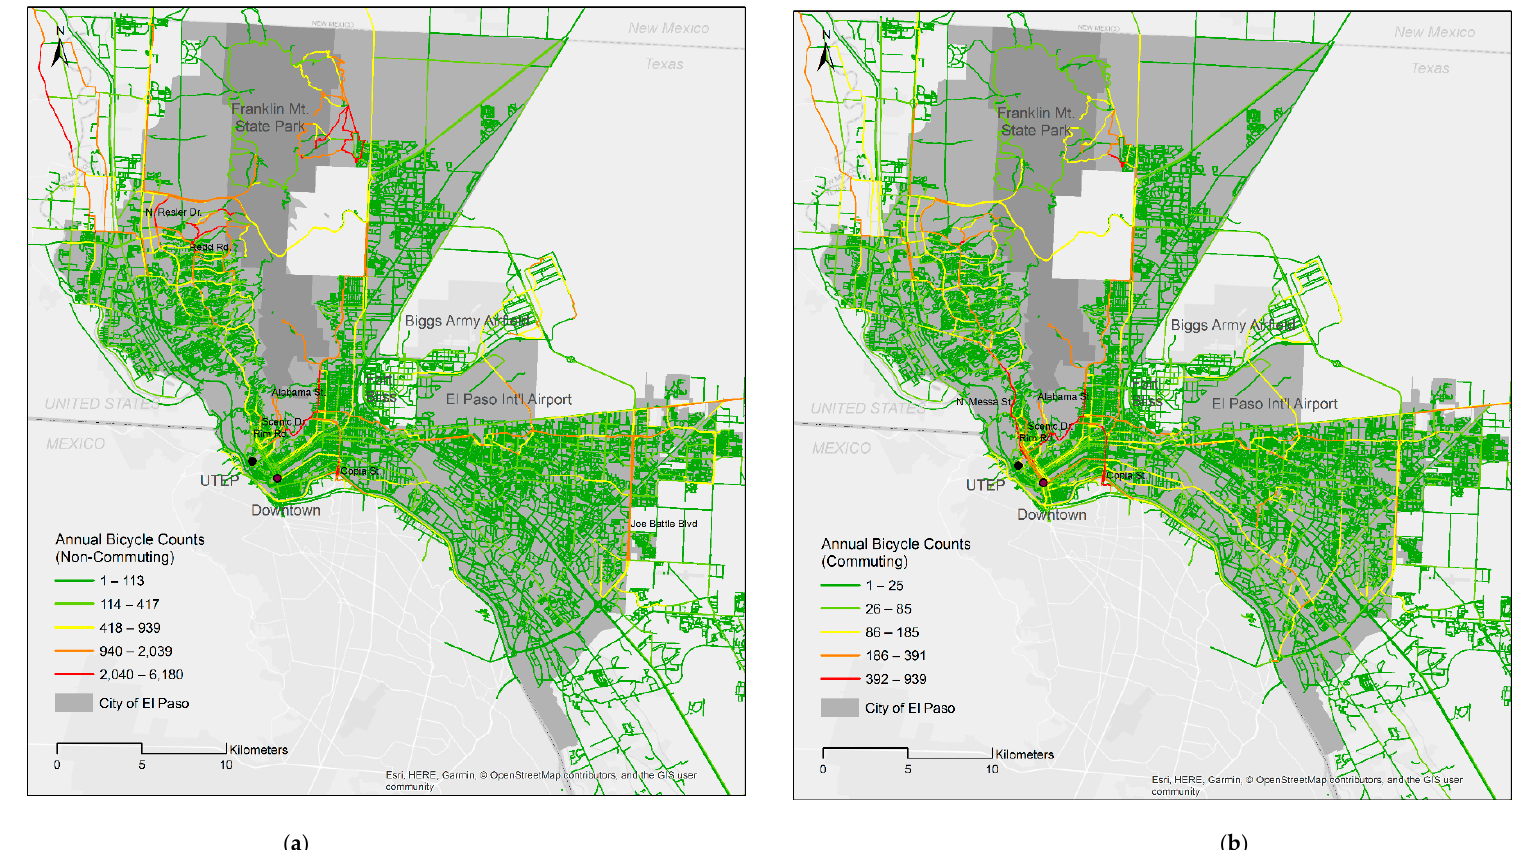
Figure 2. Distribution of bicycle activities by trip purpose (data licensed by Strava (Base map: OpenStreetMap)). ( a ) Annual bicycle counts (non-commuting); ( b ) Annual bicycle counts (commuting).